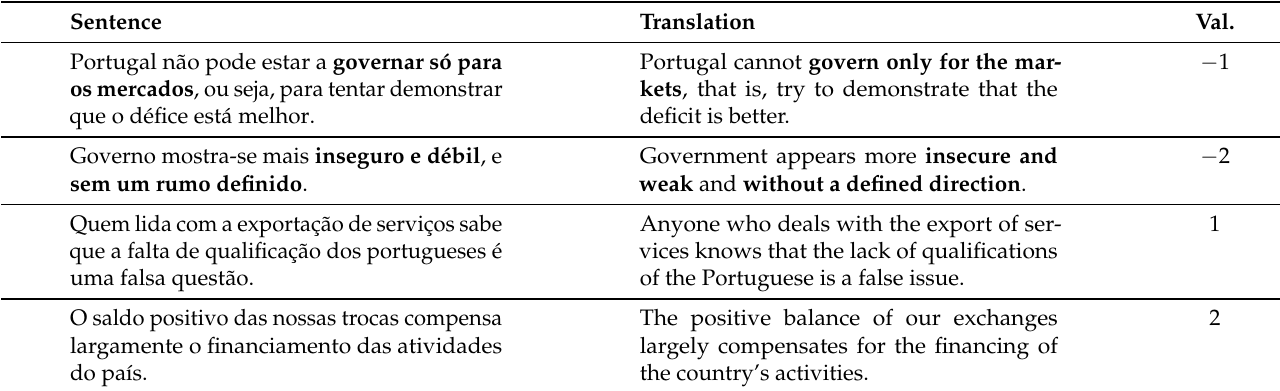
Table 1. Examples of some sentences and ratings.